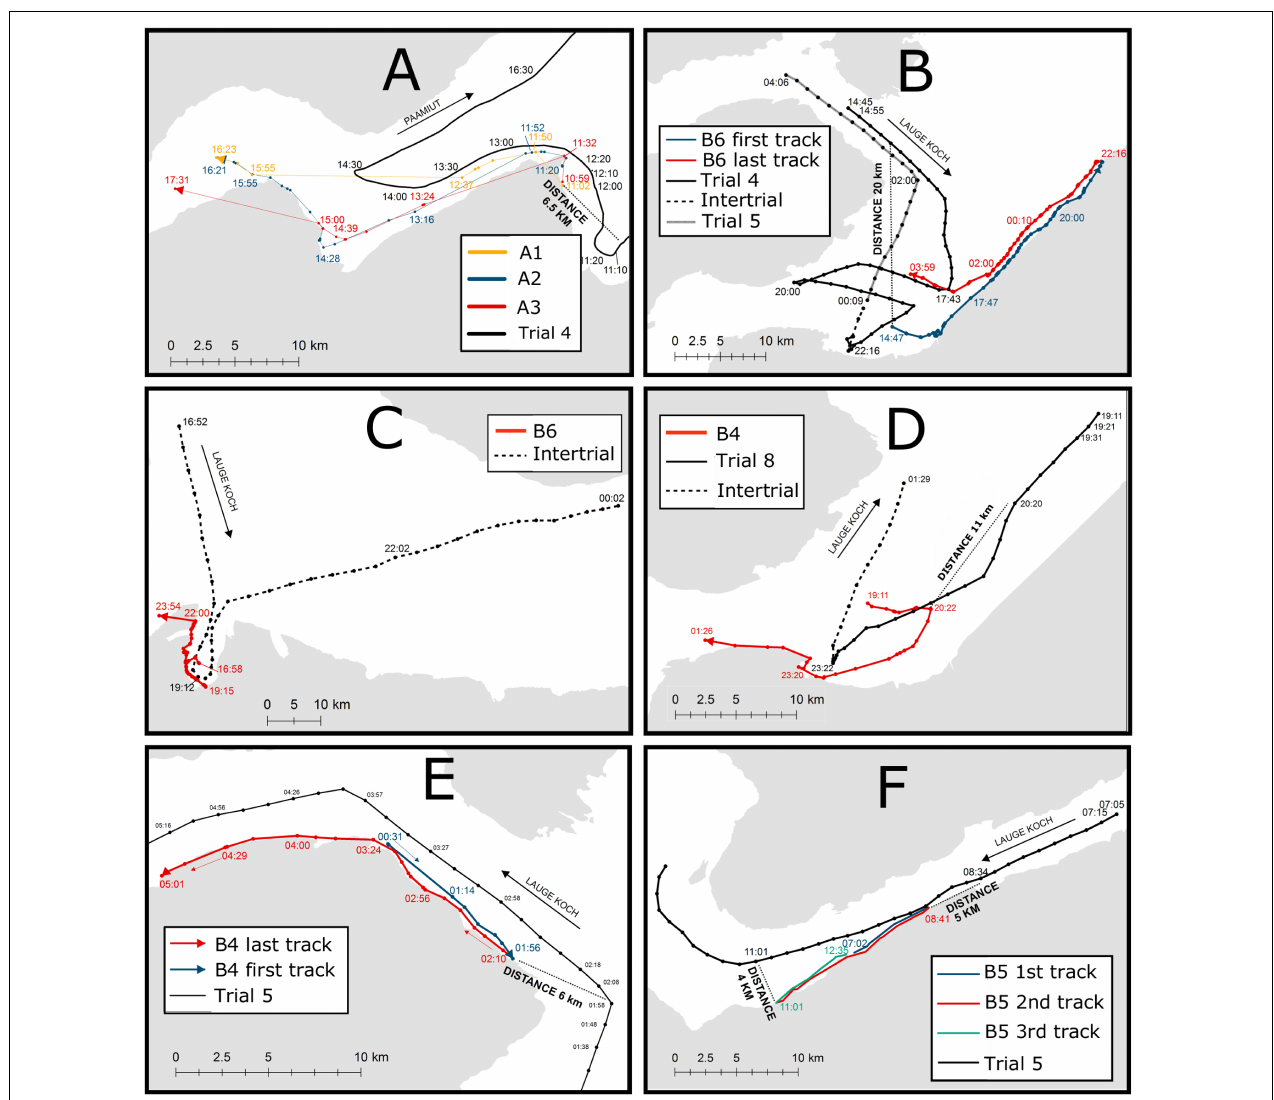
FIGURE 7 | Whale track examples in the presence of approaching vessels, for three different contexts: whales offshore, nearshore, or in a cul-de-sac at the onset of exposure. (A) Three whales (A1, A2, and A3) near the coast on August 16, 2017. The whales were in Outer Gåsefjord when they first encountered the vessel at a distance of ∼ 6 km. They immediately headed north, then west into Gåsefjord, following the coast southwestward while trailed by the vessel, and continued into the inner part of Gåsefjord. (B) B6 offshore on August 26, 2018. The whale was in line of sight with the vessel at a distance of ∼ 24 km. It moved towards the shore and headed northeast away from the vessel. When 34 km from the vessel, it reversed direction and returned along the coast. At 02:00, when the vessel was ∼ 12 km away and receding, the whale headed offshore. (C) B6 in a cul-de-sac during an intertrial on September 1, 2018. The vessel was inside the bay between 18:12 and 20:32, and the whale remained close to the coast until it could leave the bay after 22:00. (D) B4 offshore on August 29, 2018. The whale was traveling east but moved south towards the coast when the vessel was ∼ 11 km from the whale. (E) B4 near the coast on August 27, 2018. The whale was first heading southeastward along the coast at 00:31, but at 01:56, it may have sensed the approaching vessel, which was then at a distance of 6 km. The whale then turned around and headed northwest, retracing its route while being followed by the vessel. (F) B5 near the coast on August 27, 2018. The whale was heading east but reversed course when the vessel was ∼ 5 km away. After the vessel passed the whale at a distance to the ship of ∼ 4 km, the whale reversed course again. The dotted lines indicate intertrials, and the full lines indicate